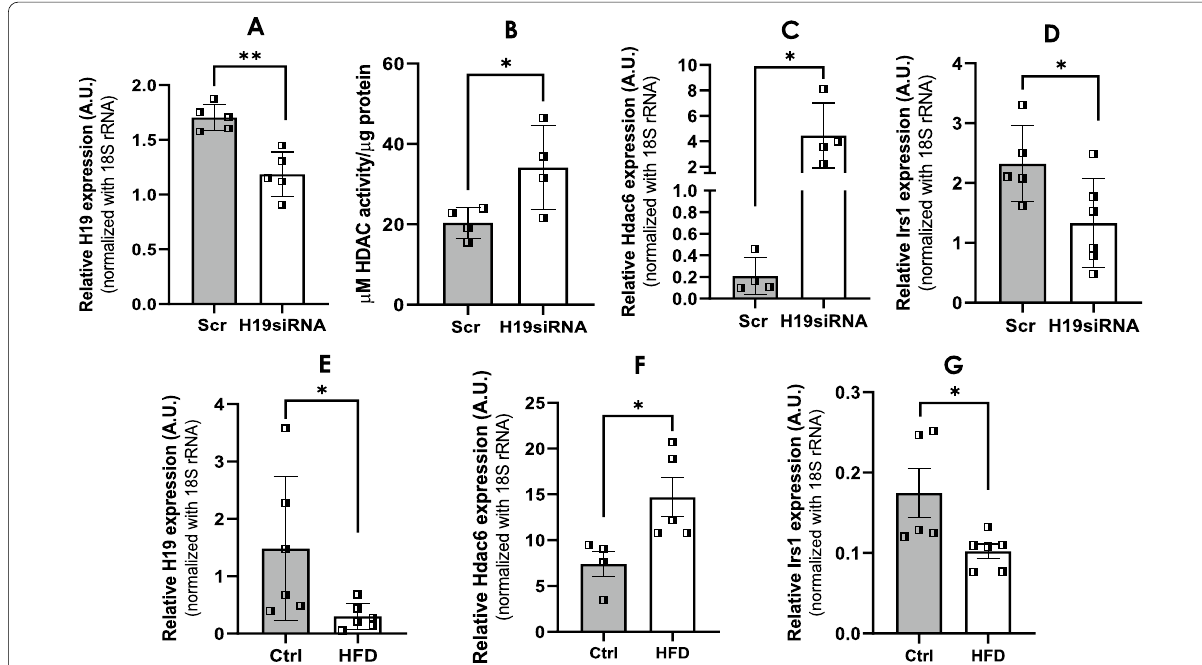
Fig. 6 In-vivo H19 inhibition alters HDAC6 and IRS1 levels in the skeletal muscle of mice. A Mice were injected (i.v) with either the scramble or H19 siRNA (3 mg/kg body weight) as described in a previous study. Skeletal muscle tissues were isolated and the levels of H19 were analyzed by qRT-PCR. 18S rRNA was taken as the normalization control. B Skeletal muscle tissues from scramble and H19 siRNA injected mice were lysed and 90 µg of tissue was assayed for HDAC activity as described in the “Materials and methods” section. Values obtained were normalized to the total protein content. Total RNA (1 µg) isolated from skeletal muscle tissues of both groups of mice was reverse transcribed and the transcript levels of Hdac6 ( C ) and Irs1 ( D ) were assessed by qRT-PCR. 18S rRNA was taken as the loading control. Mice were fed either chow diet or high fat diet and after 6 months, skeletal muscle tissues were isolated total RNA extracted (1 µg), was reverse transcribed and the transcript levels of H19 ( E ), Hdac6 ( F ) and Irs1 ( G ) were evaluated by qRT-PCR. 18S rRNA was used as the loading control. Values presented are means each group. *p 0.05; **p ≤ ≤